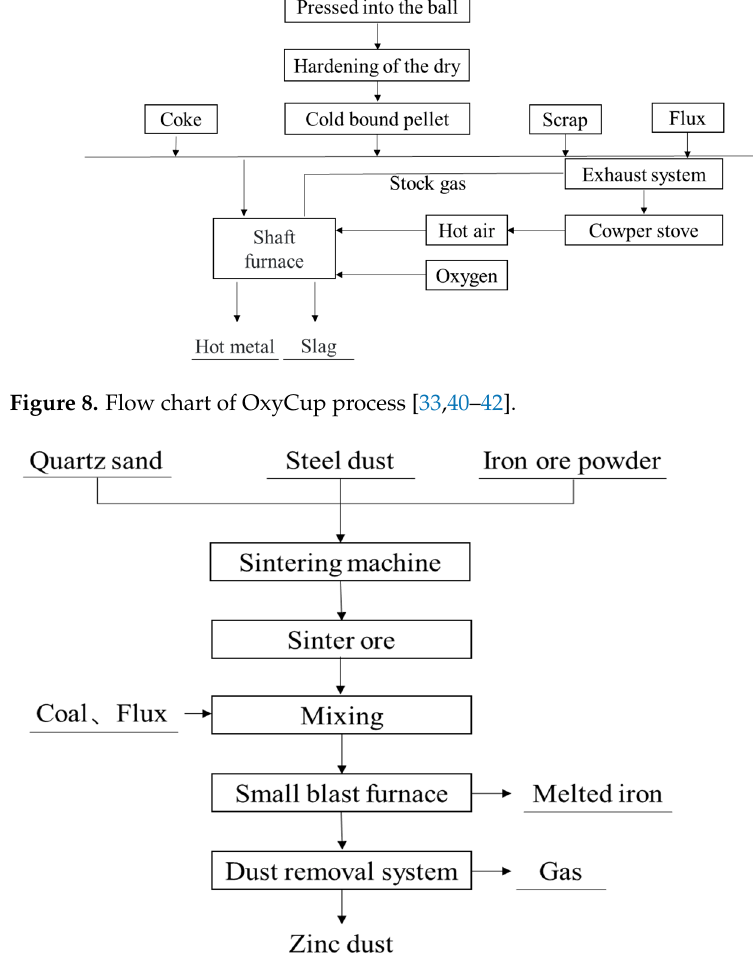
Figure 10. Flow chart of DK process [34]. Figure 9. Flow chart of DK process